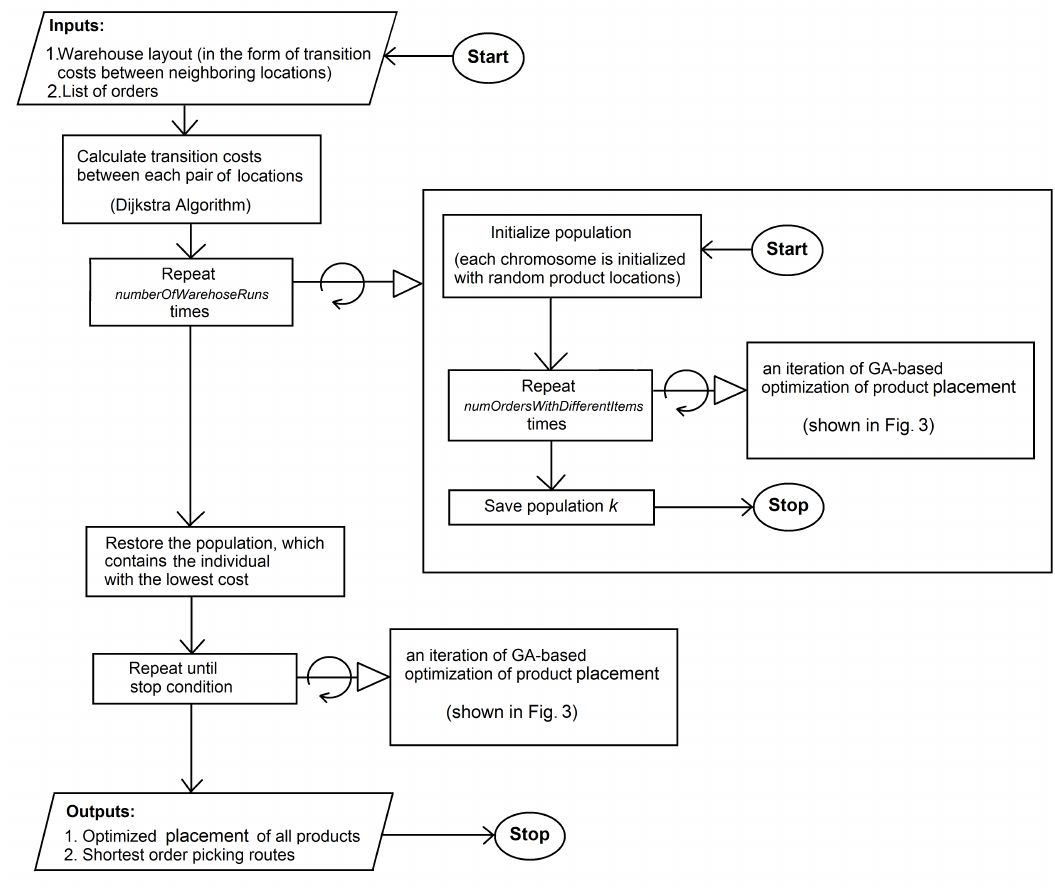
Figure 2. Product Placement Optimization (main